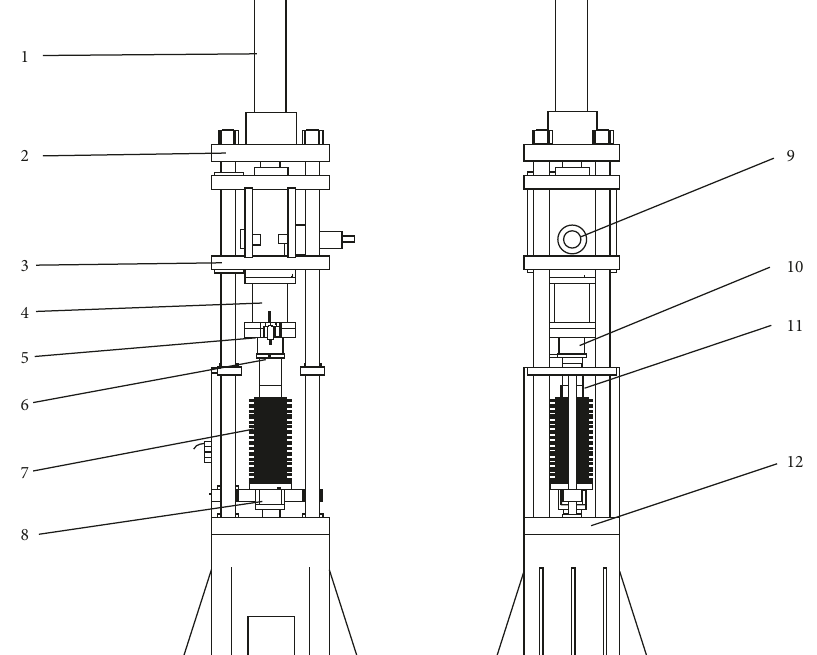
Figure 1: Structure of the modified HVC machine: 1, main hydraulic cylinder; 2, beam; 3, movable beam; 4, hydraulic cylinder; 5, displacement sensor; 6, spring flange; 7, disc spring; 8, impact hammer; 9, locking hydraulic cylinder; 10, piston rod; 11, guide bar; 12, lower beam.